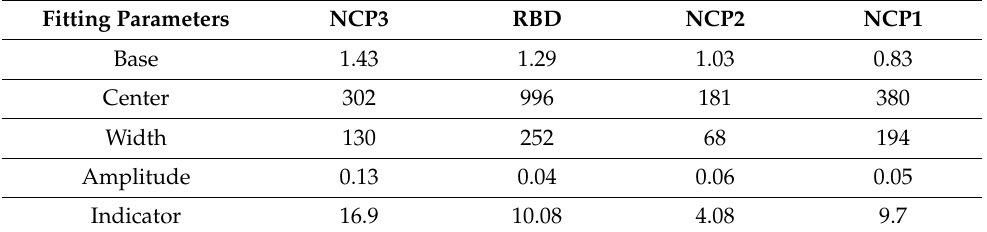
Table 2. Fitting parameters for interaction profiles depicted in Figure